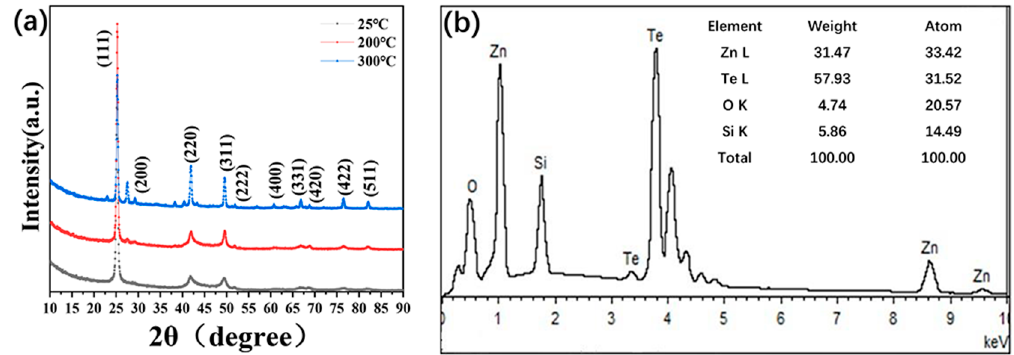
Figure 2. ( a ) X-ray diffraction (XRD) pattern of the ZnTe films at different annealing temperatures; ( b ) Energy dispersive spectrometry (EDS) of the as-prepared ZnTe sample.